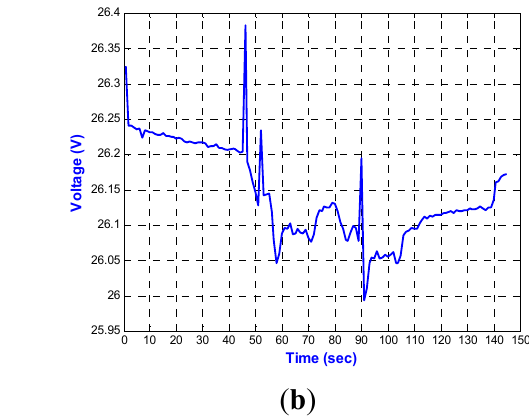
Figure 20. The humanoid robot test. ( a ) Current profile; ( b ) Voltage